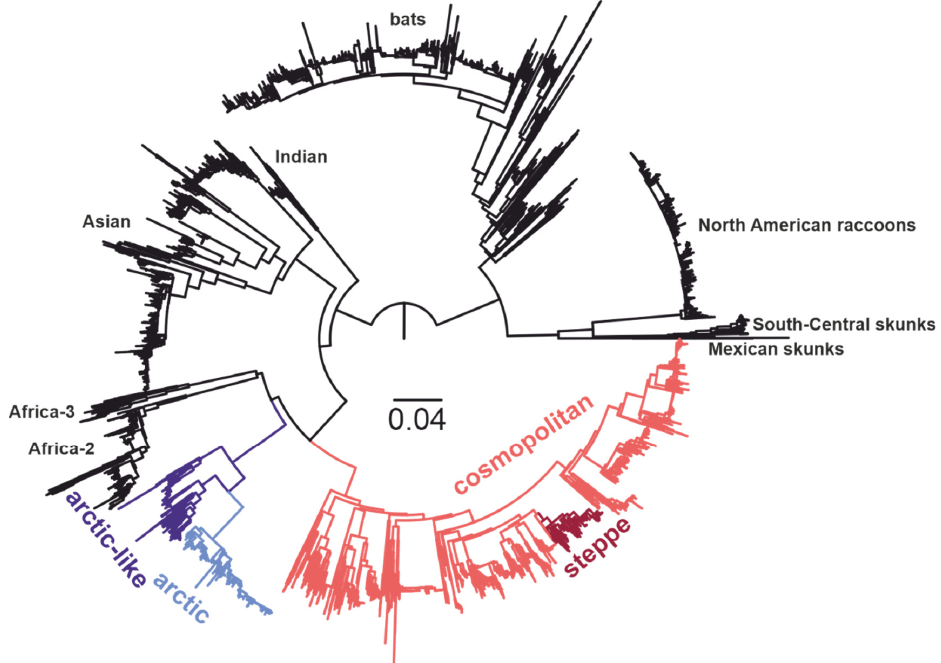
Figure 1. Maximum likelihood tree for RABV (alignment length = 981 nucleotides, number of sequences = 7565). RABV groups analyzed here are indicated by color: cosmopolitan group—pale red; steppe subgroup of the cosmopolitan group—dark red; Arctic-like group—dark blue; Arctic group—pale blue.